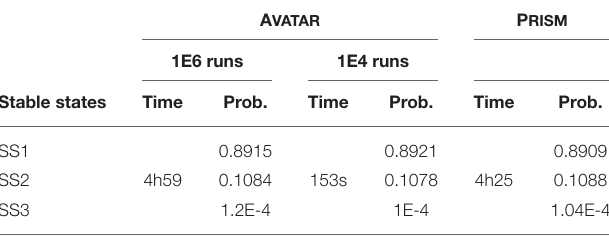
TABLE 4 | Assessing attractor probabilities for the sp2 model with A VATAR and P RISM . A VATAR P RISM 1E6 runs 1E4 runs Stable states Time Prob. Time Prob. Time Prob. 0.8909 1.04E-4 Probabilitiesreturnedby Avatar arequitesimilarwhenconsideringalowernumberofruns, indicating that it is possible to quickly obtain good estimates of reachability probabilities in a much shorter